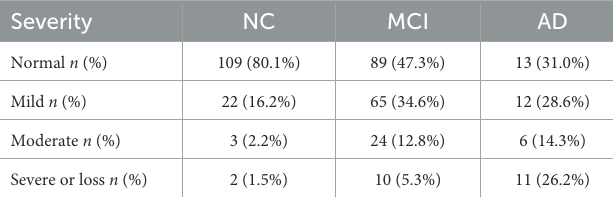
TABLE 3 Functional impairment of olfactory identification ability in the three groups of